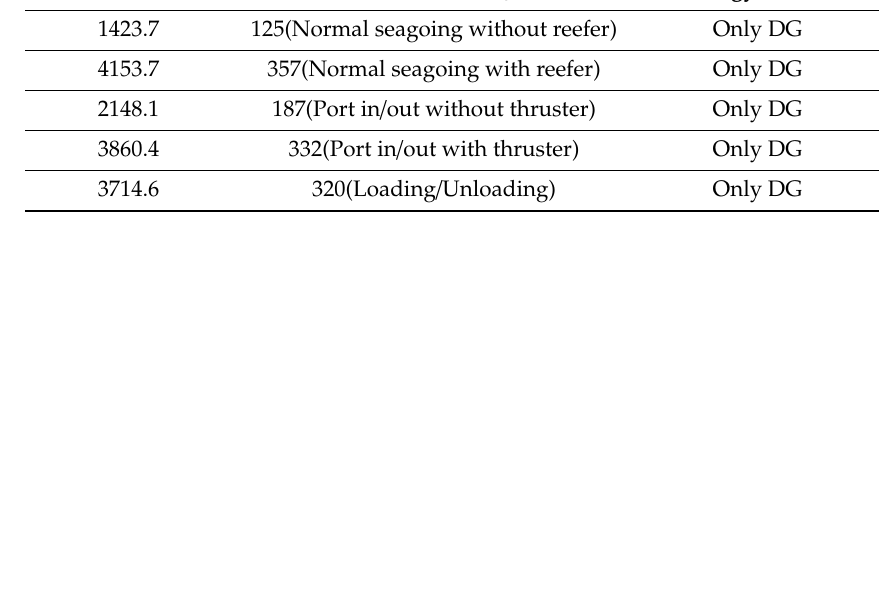
Table 3. Experimental results of the generator reference voltage with respect to changes in the system speed using the neural network controller .